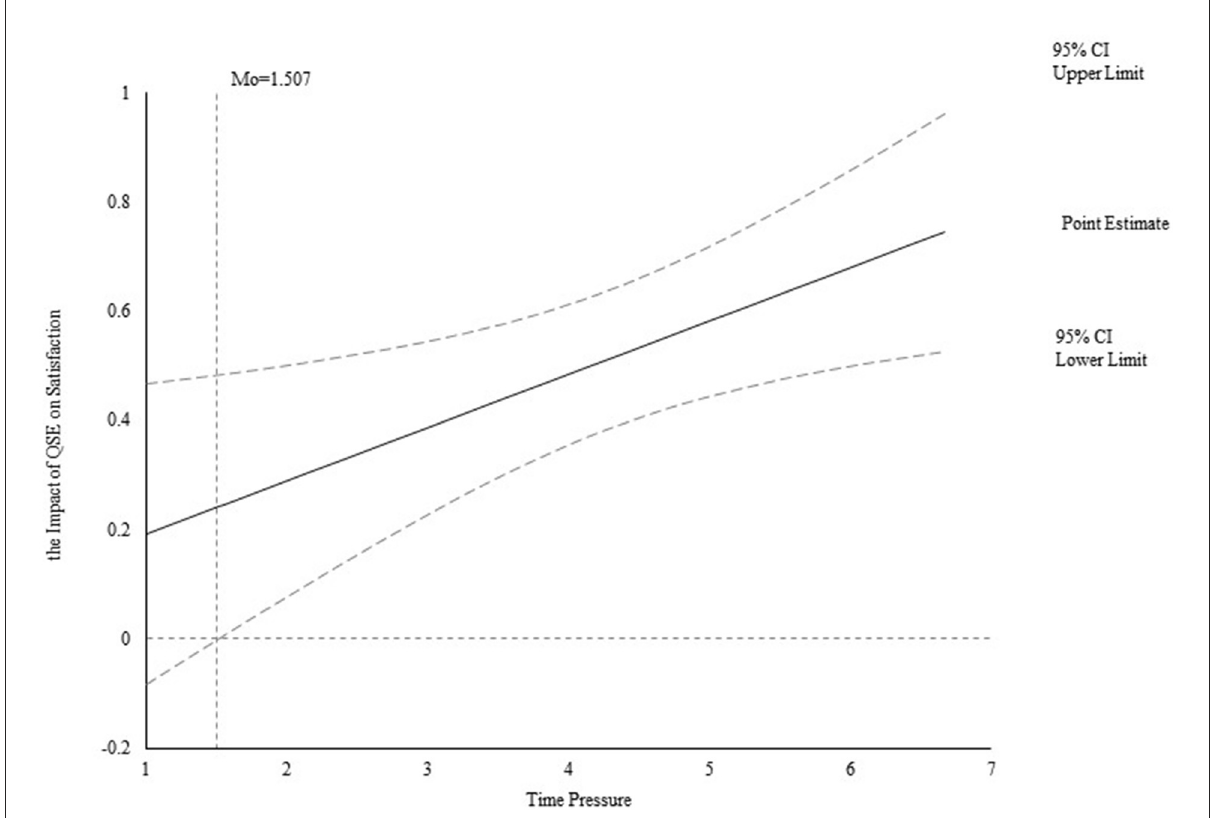
FIGURE3 Effect of time pressure on the relation between QSE and